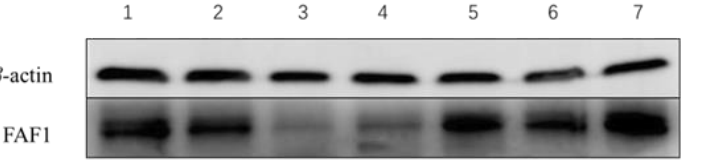
Figure 2. β -actin and FAF1 protein in testes of different ages.